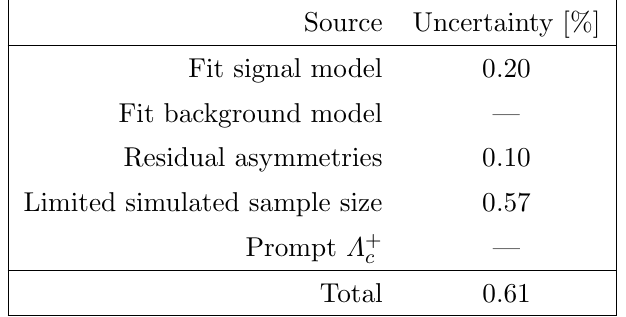
Table 2 . Systematic uncertainties on (cid:1) A wgt uncertainty is assessed to be